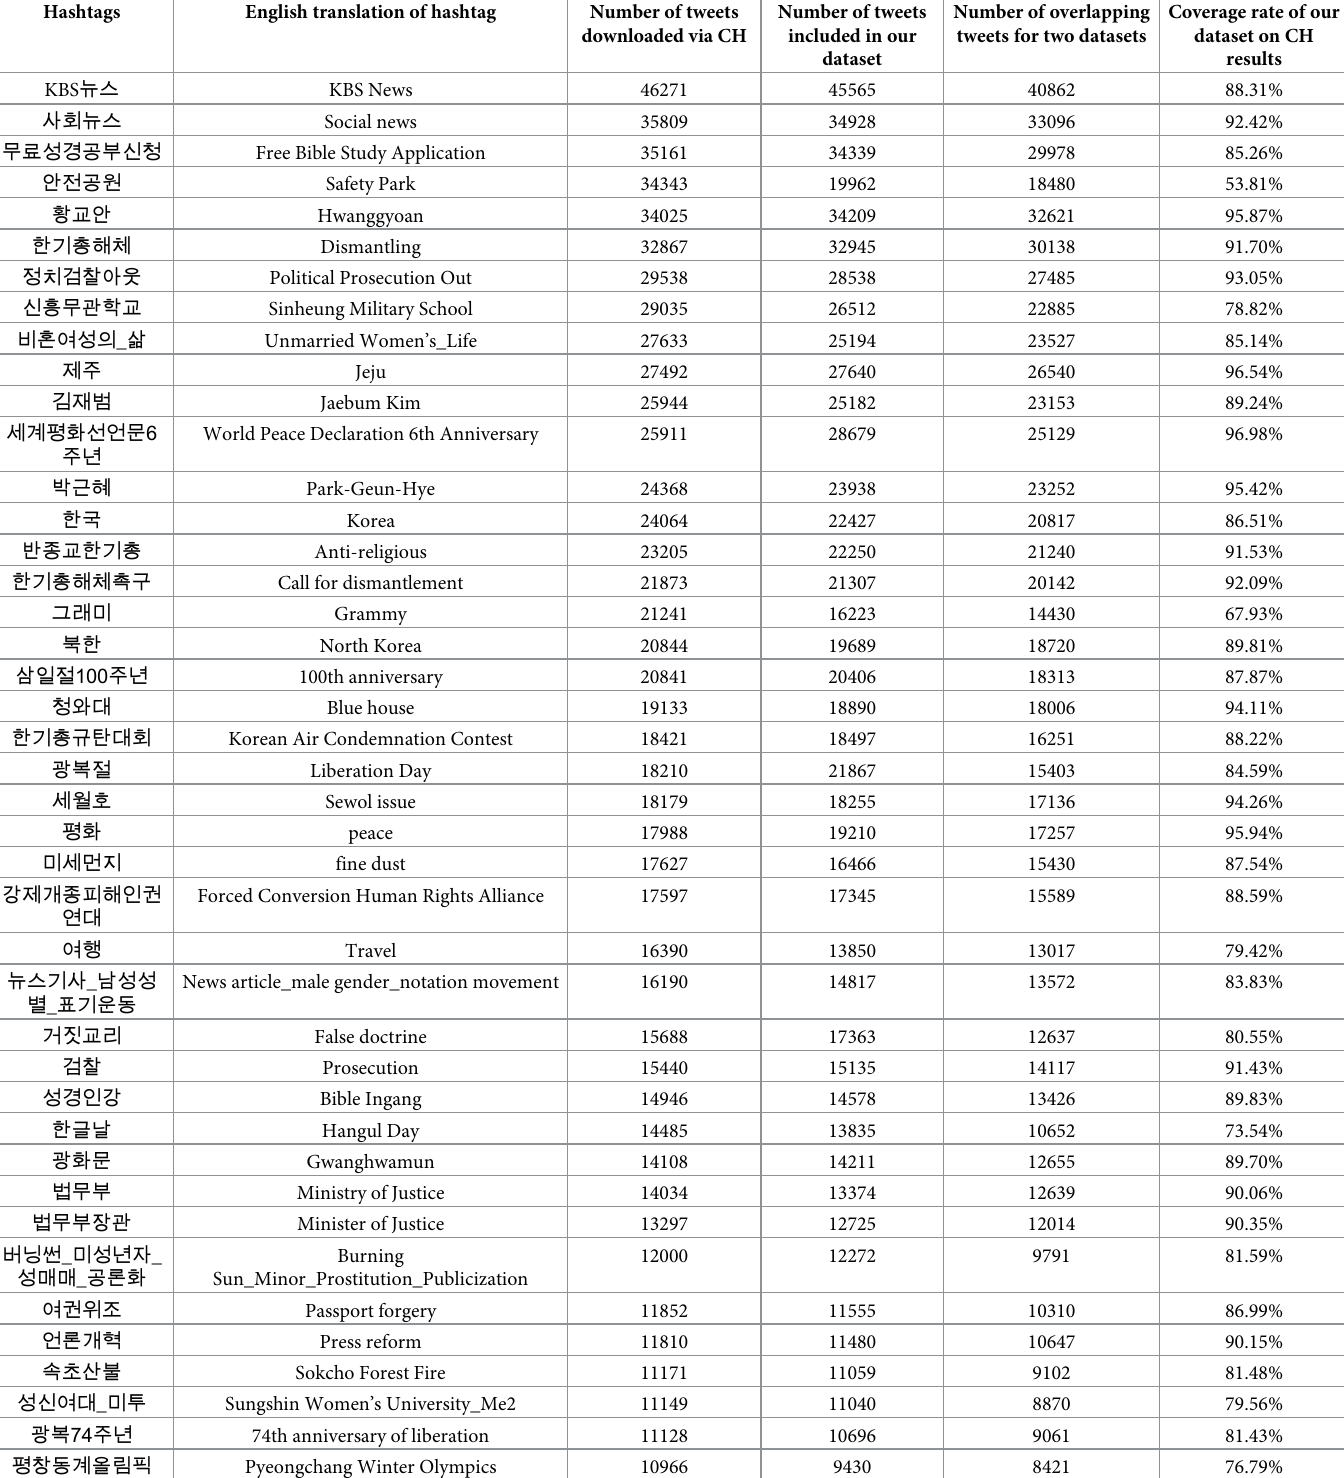
Table 2. Comparison between hashtag searching results via Twitter firehose API and our